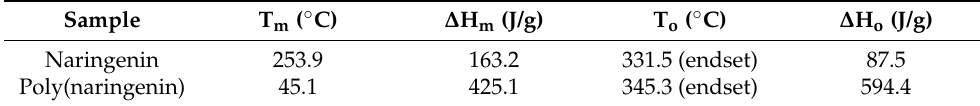
Figure 8. DSC thermograms of naringenin and poly(naringenin). Table 2. DSC analysis of naringenin and poly(naringenin).